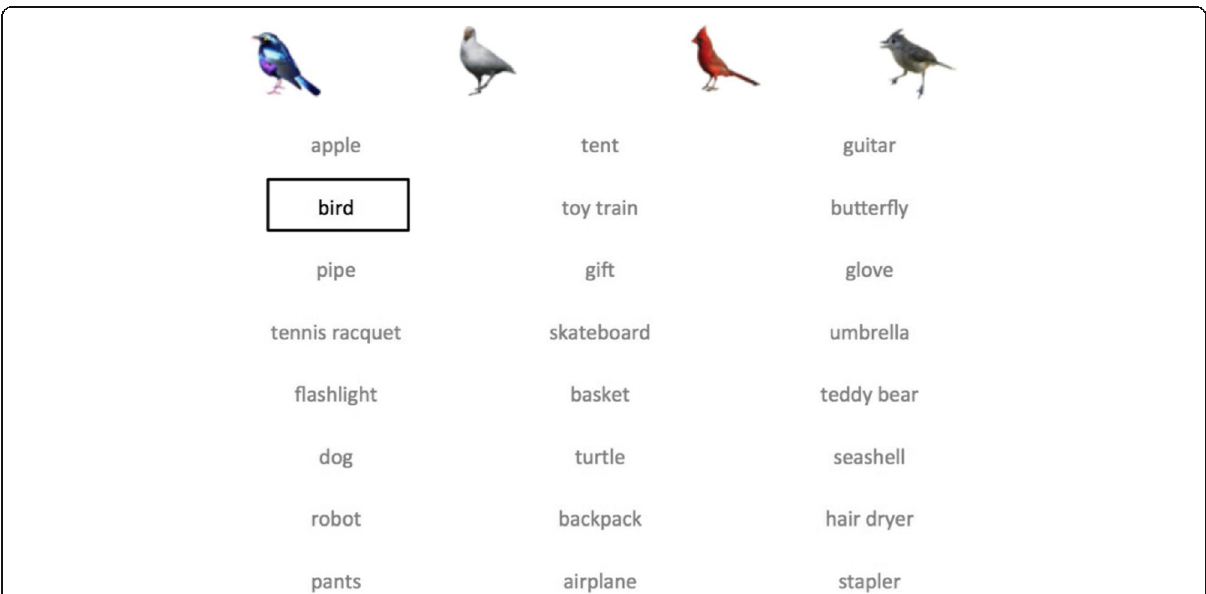
Fig. 1 Sample display for the memorization of target categories. Targets were highlighted in black for 3 s each: 4 (out of a possible 16) randomly selected exemplar images corresponding to the highlighted target category appeared at the top of the screen in order to familiarize the participant with the category and eliminate any